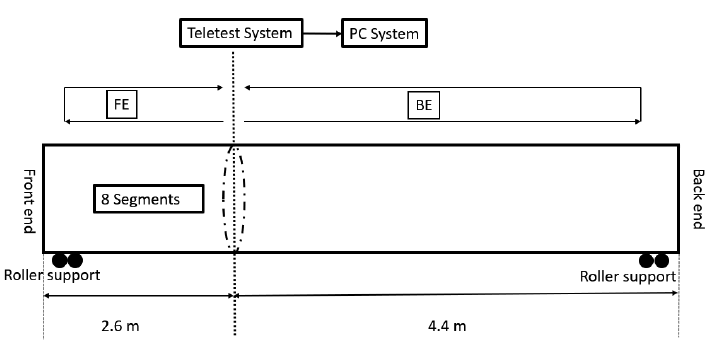
Figure 6. Schematic diagram of pipe experiential set-up composed of roller support, Teletest MK3 system and PC system.